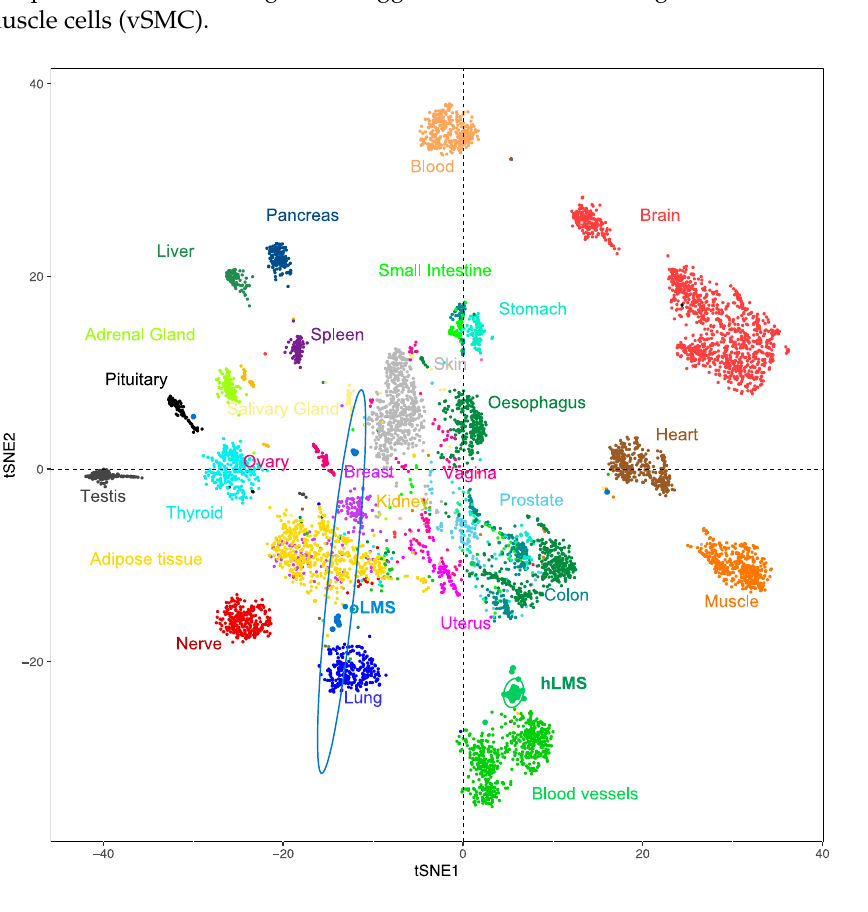
Figure 2. t-SNE clustering from most expressed hLMS 100 genes in 7414 normal and LMS samples from the GTEX dataset. Each point represents a sample, and the color code corresponds to the tissue type.